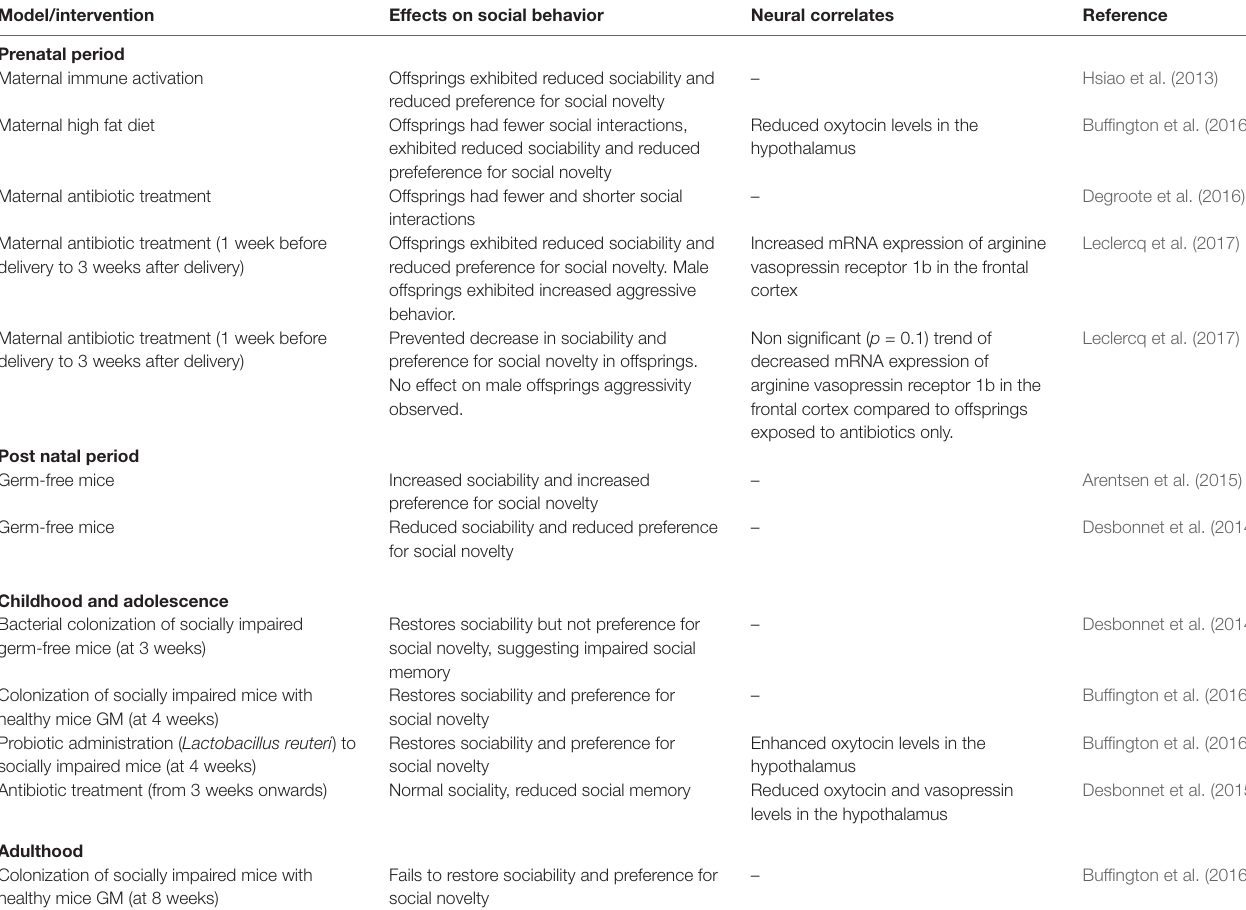
TABLE 1 | Perturbation of the gut microbiota (GM) can affect social behavior in rodent